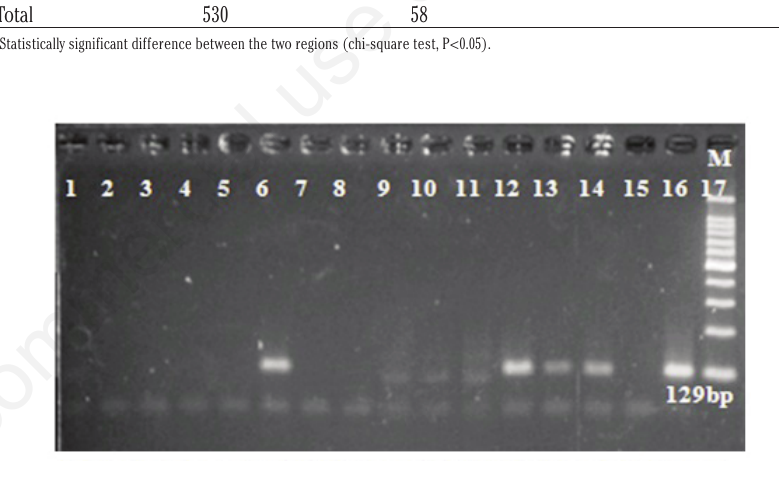
Figure 3. PCR amplification and detection of the 129-bp fragment of M.leprae DNA, visualized on 3% agarose gel electrophoresis. Lane 17 is 100 bp DNA Ladder (M). Lane itive control ( M.leprae Thai-53).